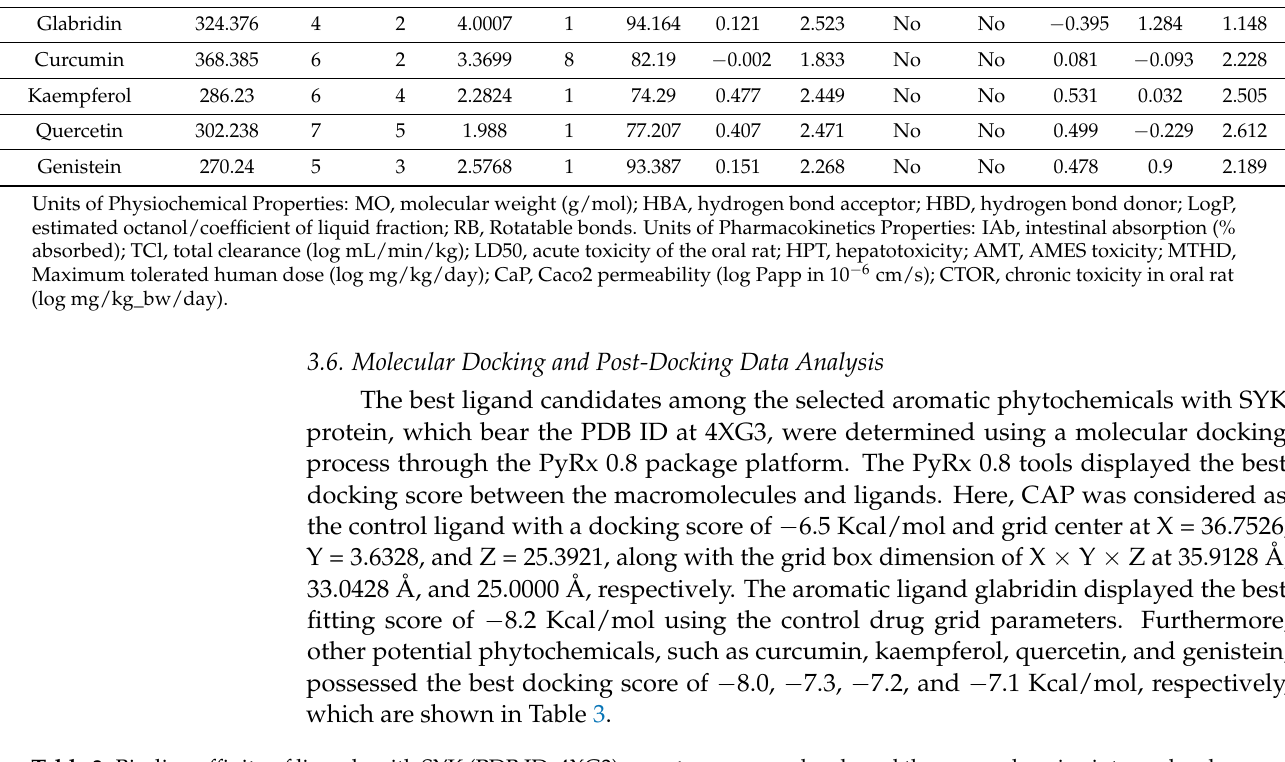
Table 3. Binding affinity of ligands with SYK (PDB ID: 4XG3) receptor macromolecule and the comprehensive intermolecular interaction between them as compared with the control